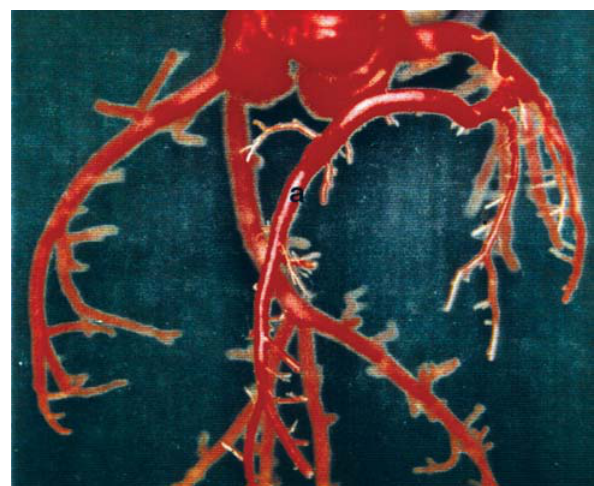
Fig. 2 - Dominância direita - a: ramo interventricular posterior